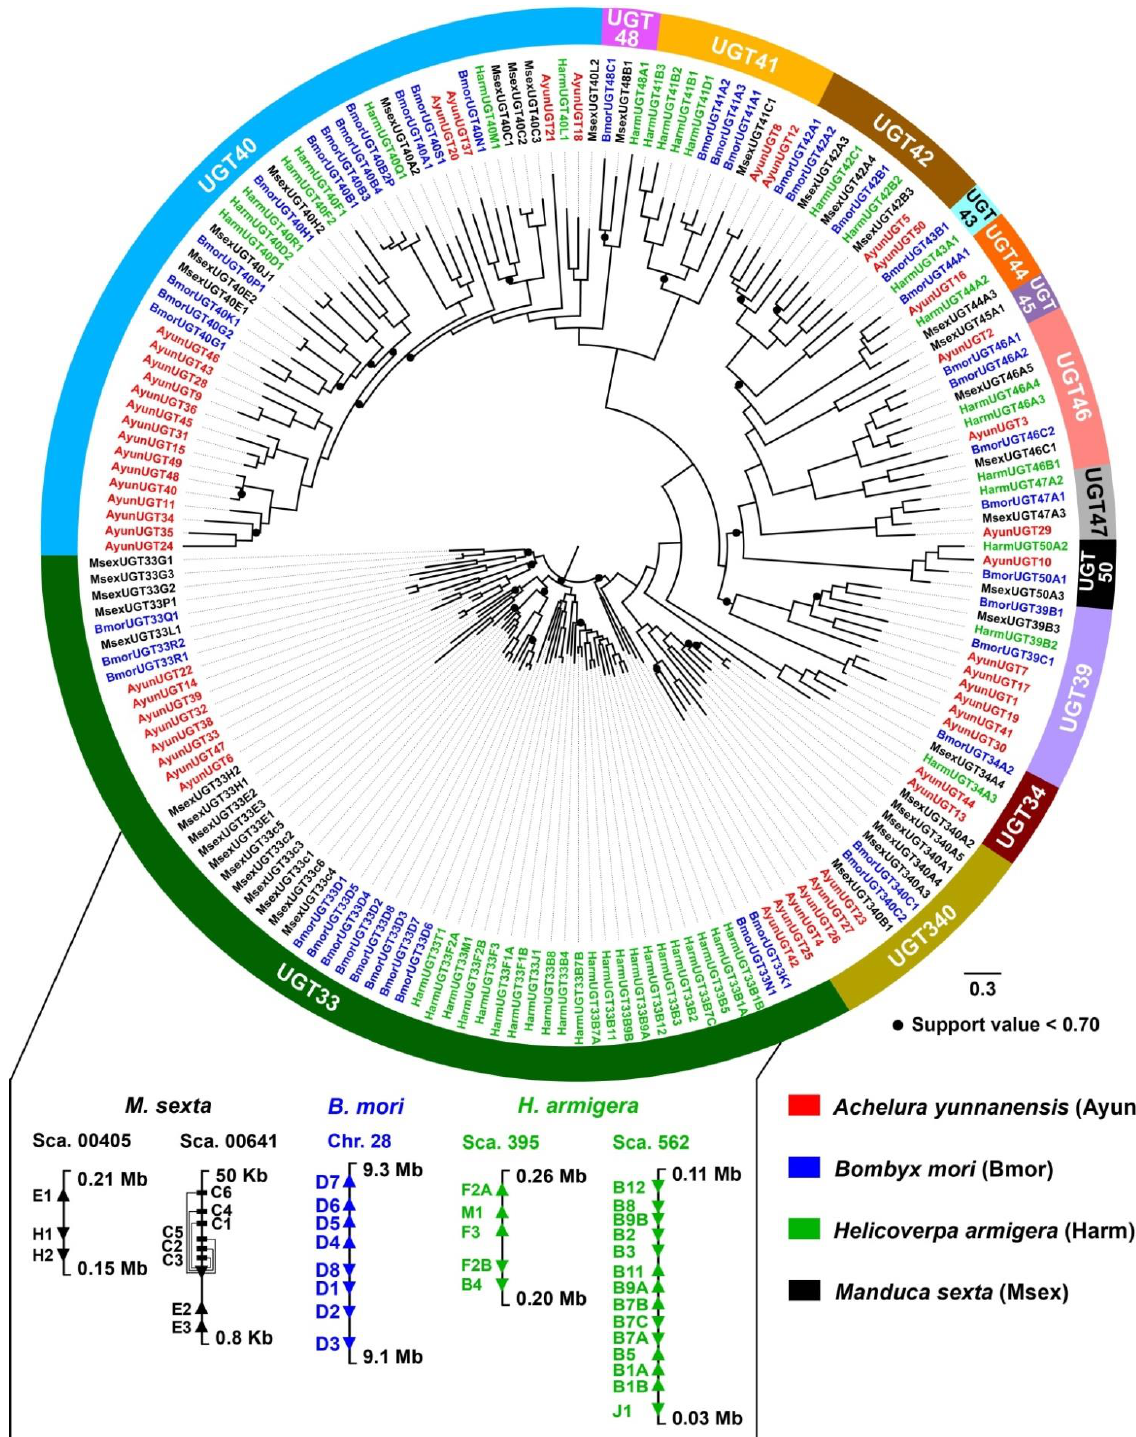
Figure 2. Phylogenetic tree of UGTs in four moths. Based on the classification of UGT subfamilies in moth species, AyunUGTs clustered into 12 subfamilies. Newly identified AyunUGTs are shown in red. In the UGT33 subfamily, three typical UGT clusters in three species with available genomes are presented on scaffolds (Sca.) or chromosomes (Chr.). Arrows indicate the transcriptional orientation of genes. In M. sexta , six alternative splicing variants (UGT33C1 – UGT33C6) sharing a common 3 ’ -terminus are indicated by solid lines.